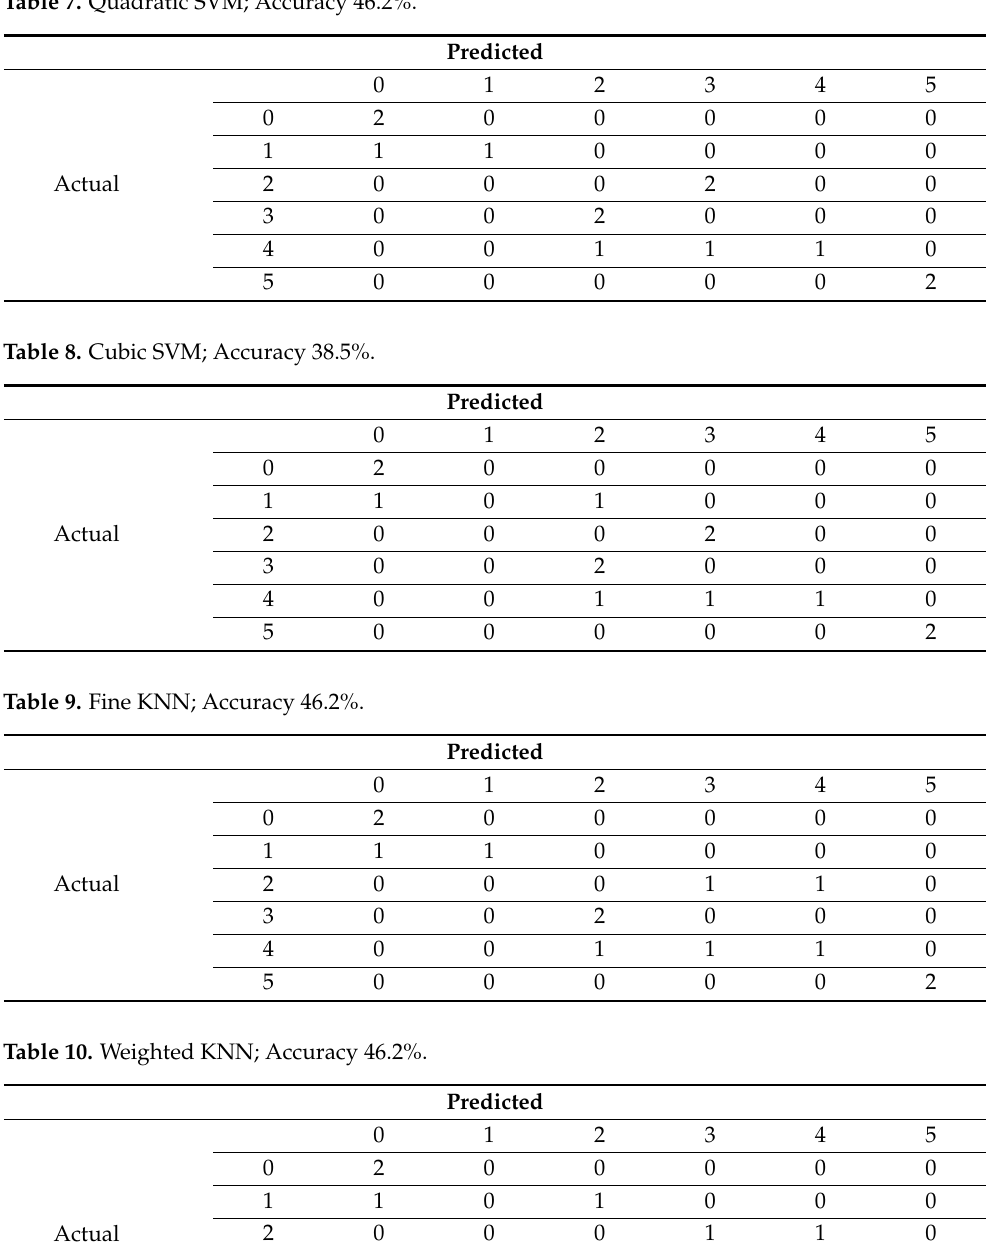
Table 7. Quadratic SVM; Accuracy 46.2%.